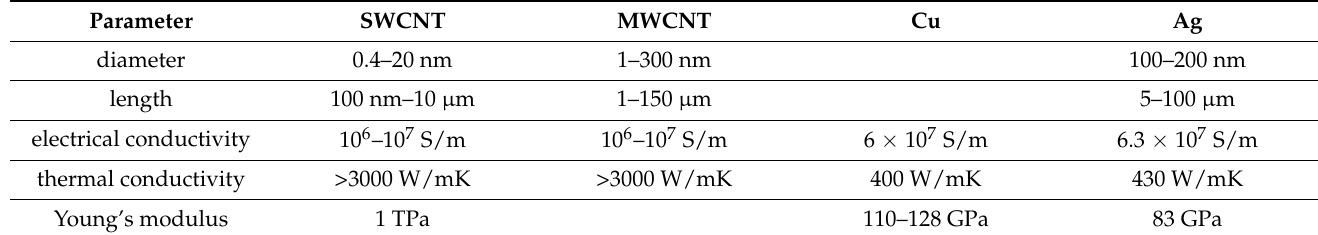
Table 2. Specific properties of CNTs versus other sensing materials